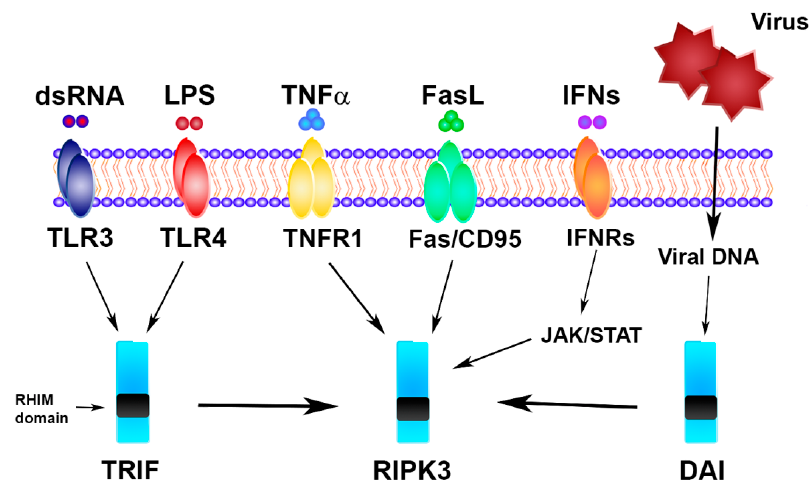
Figure 1. Necroptosis signaling triggers. TLR, Toll-like receptor; LPS, lipopolysaccharide; TNF α , tumor necrosis factor alpha; TNFR1, tumor necrosis factor receptor; FasL, Fas ligand; IFN, interferon; IFNR, interferon receptor; TRIF, Toll / interleukin-1 receptor (TIR) domain-containing interferon- β ; DAI, DNA-dependent activator of IFN regulatory factors; RHIM, RIP-homotypic-interaction-motif domain; RIPK3, receptor-interacting protein kinase